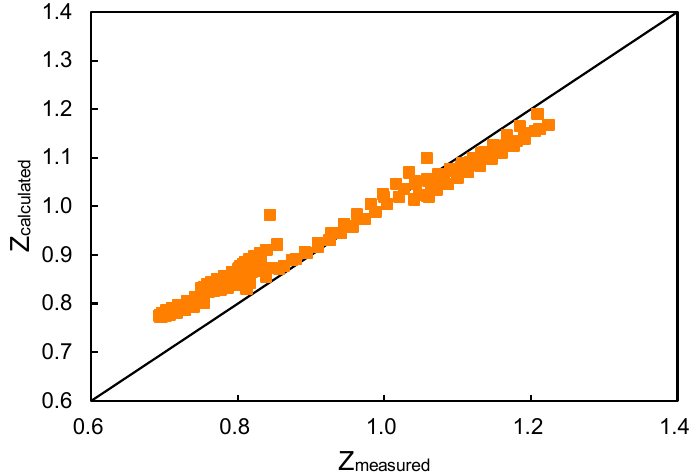
Figure 2. The cross plot of compressibility factors as calculated by the method proposed in this paper with the measured data of the three condensate gas samples.